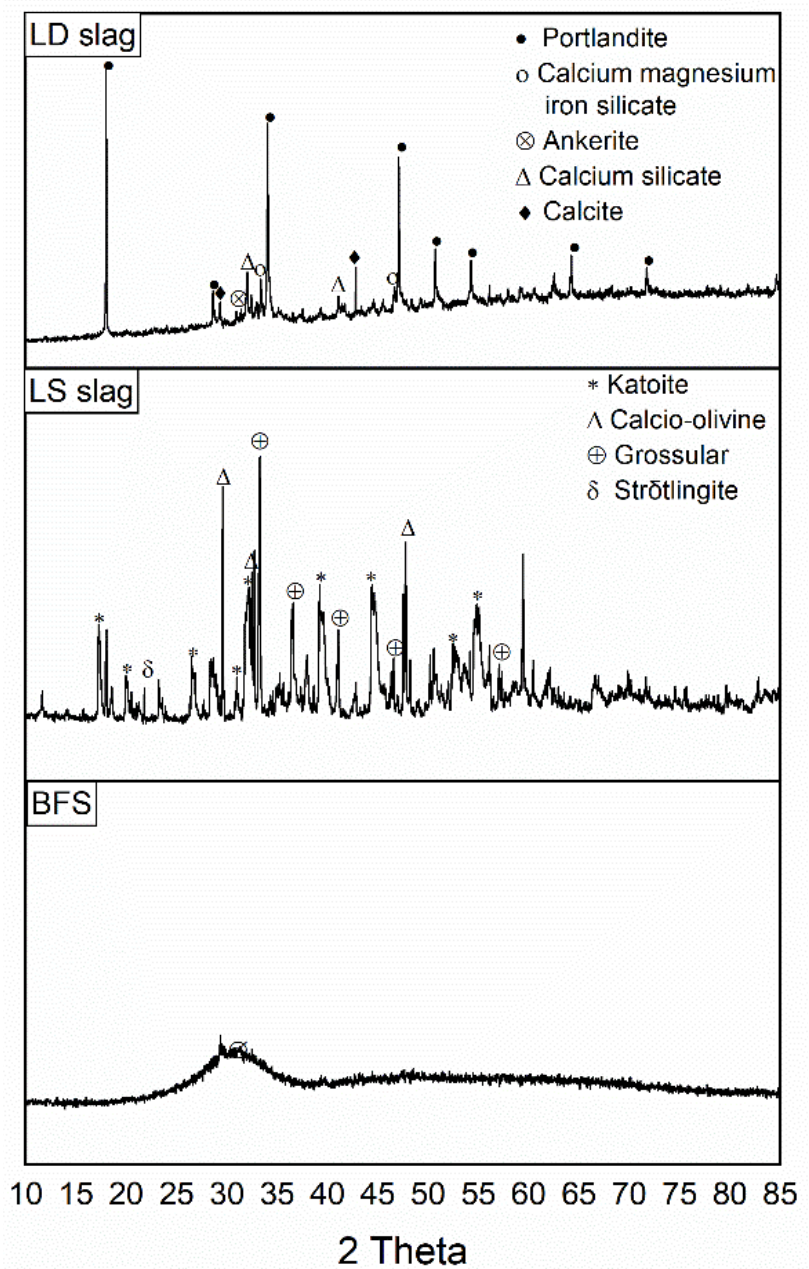
Figure 1. X-ray diffraction (XRD) pattern of raw materials LD slag, LS slag, and BFS. Calcium carbonate (ICDD 01-071-3699) and katoite (ICDD 01-077-0240) were identi- fied as major peaks after geopolymerization for GP (BFS, LS) and GP (LD, BFS, LS) (Figure 2). This confirms the crystalline and amorphous phases in GP (BFS, LS) and GP (LD, BFS, LS). In the X-ray diffraction analysis, there were no peaks for silicates or aluminum sili- cates for these two GP samples. Further, the above peaks confirm the possible presence of aluminum and silicon, as an amorphous phase or crystalline structure was found below the detection limit.